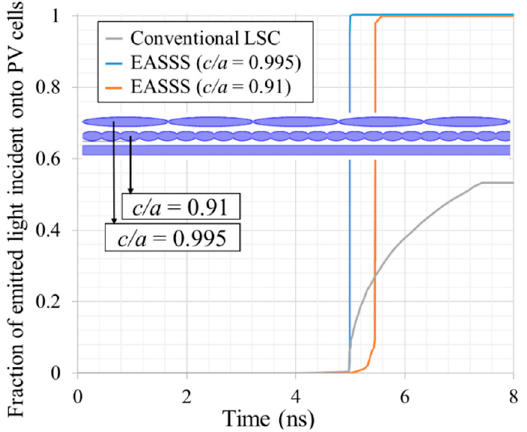
Figure 8. Radiation emitted from the center of the EASSS and conventional LSC panels incident onto the PV cells at the panel sidewalls plotted as a function of ray travelling time for h = 2 cm.